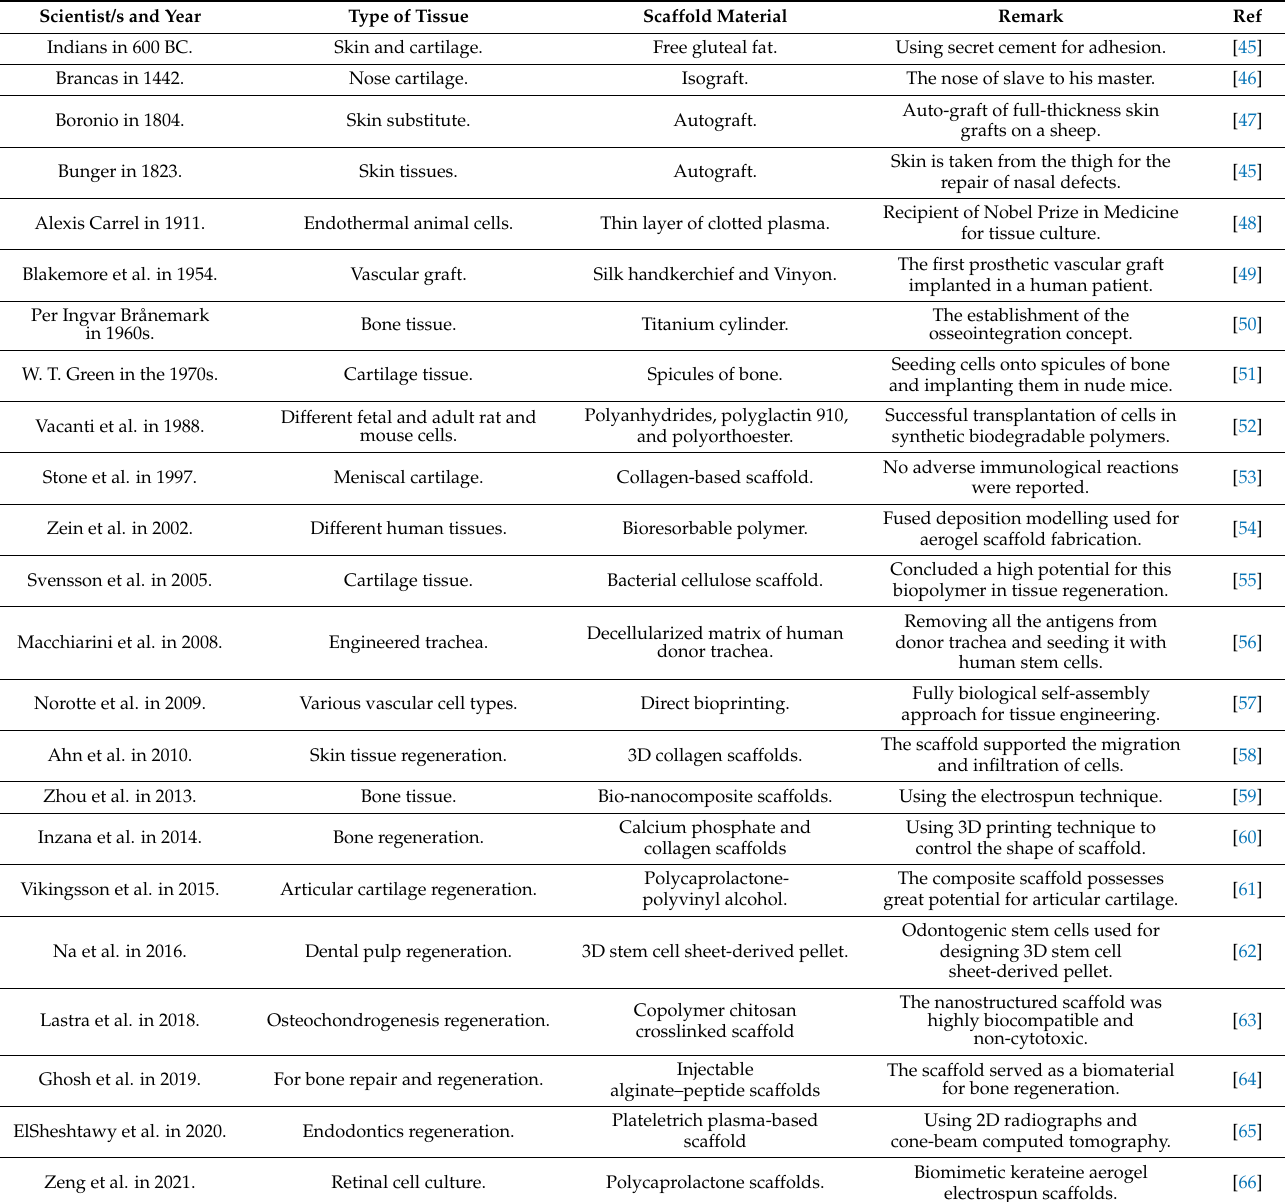
Table 1. The chronological evolution of tissue engineering and regenerative